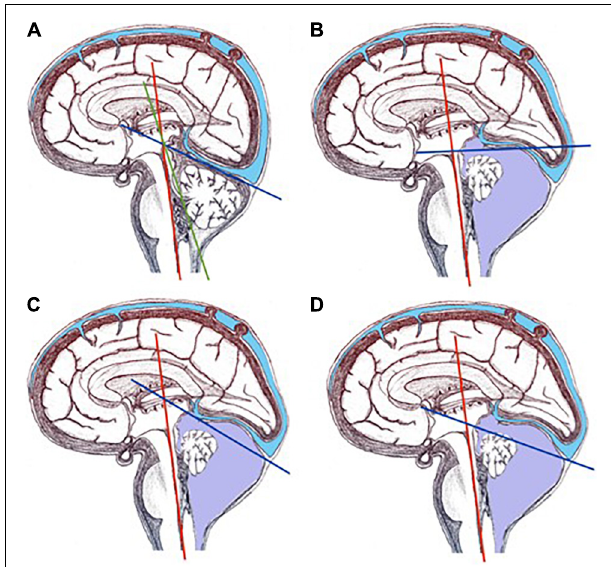
FIGURE 1 | Representation of BV and BT angles in a normal fetus and in a fetus with PFFC. (A) Represents BV (red and green lines) and BT (red and blue lines) angles in a normal fetus. (B–D) Represent BT angle in a fetus with PFFC: (B) is the angle as described by Ghi et al. (8), from the quadrigeminal plate following the tentorium surface; (C) represents the BT1 angle, defined with the line that goes from the upper insertion of the tentorium down to its insertion in the occipital bone; (D) depicts the BT2 angle, defined with the line that goes from the quadrigeminal plate to the insertion of the tentorium in the occipital bone.